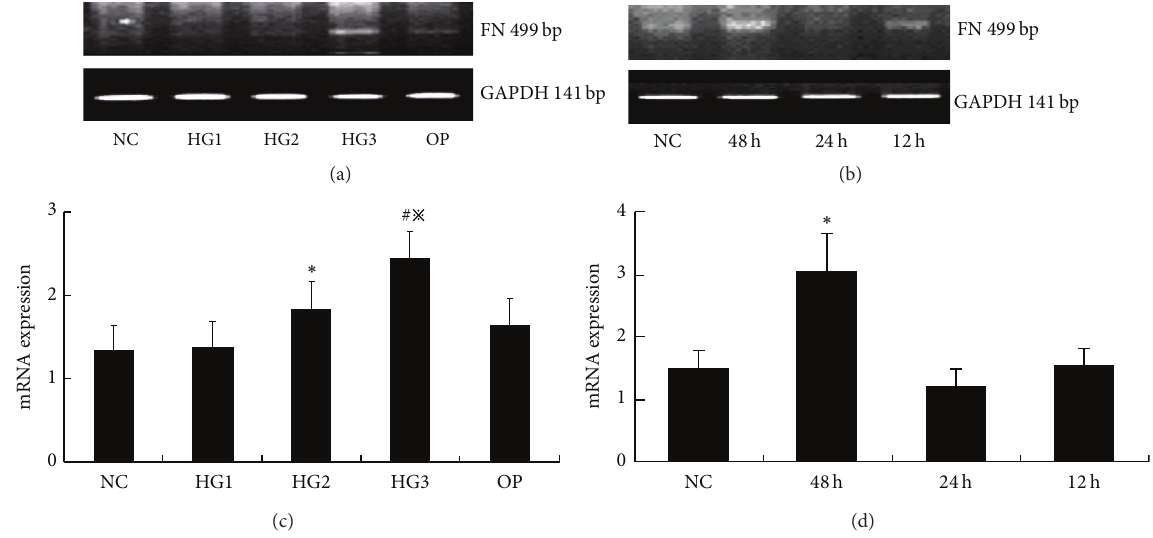
Figure 2: The mRNA levels of FN in each group of GMCs. (a) RT-PCR strip chart for different concentrations of glucose. FN mRNA increased in the high glucose group, especially in HG3 group. (c) The corresponding relative gray value statistics graph of the mRNA level. ∗ 𝑃 < 0.05 versus NC group, # 𝑃 < 0.01 versus NC group, and n 𝑃 < 0.05 versus HG2 group. (b) RT-PCR strip chart for different times. The expression of FN mRNA increased over time. (d) The corresponding relative gray value statistics graph of the mRNA level. ∗ 𝑃 < 0.01 versus NC